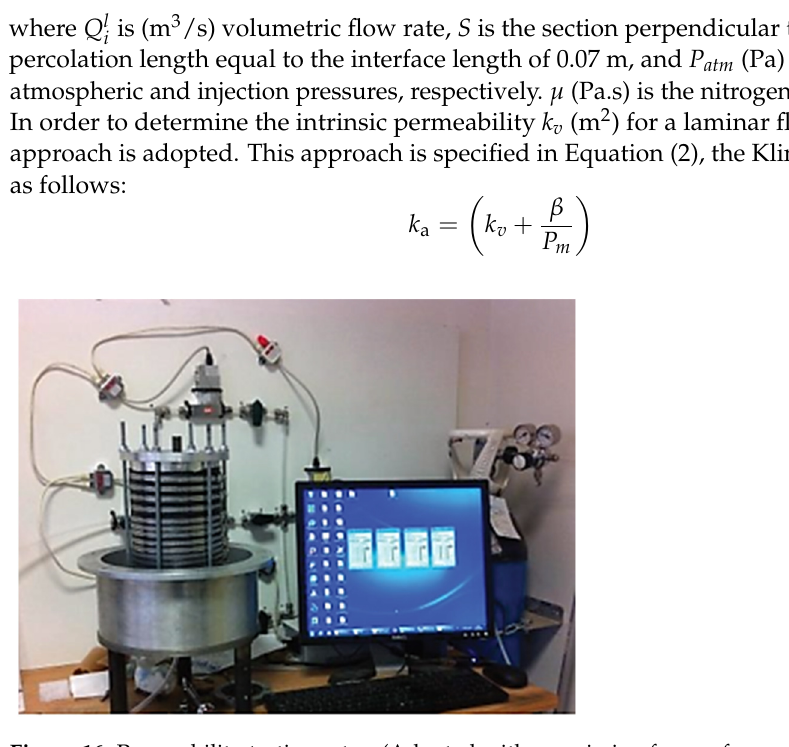
Figure 16. Permeability testing setup (Adapted with permission from reference [57]).